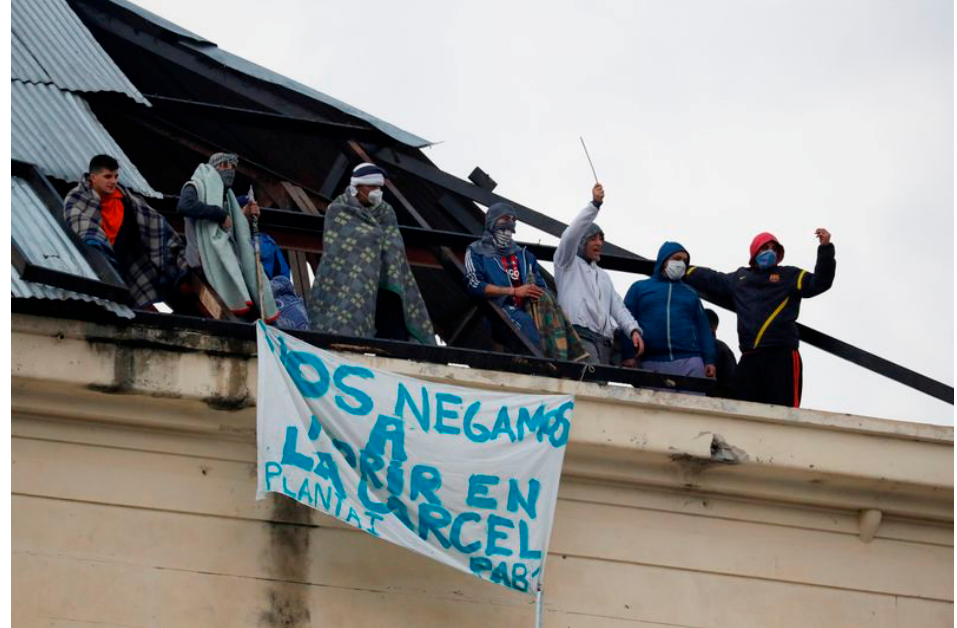
Figure 13. Argentinian prisoners protesting rising COVID-19 rates from prison overcrowding [46].